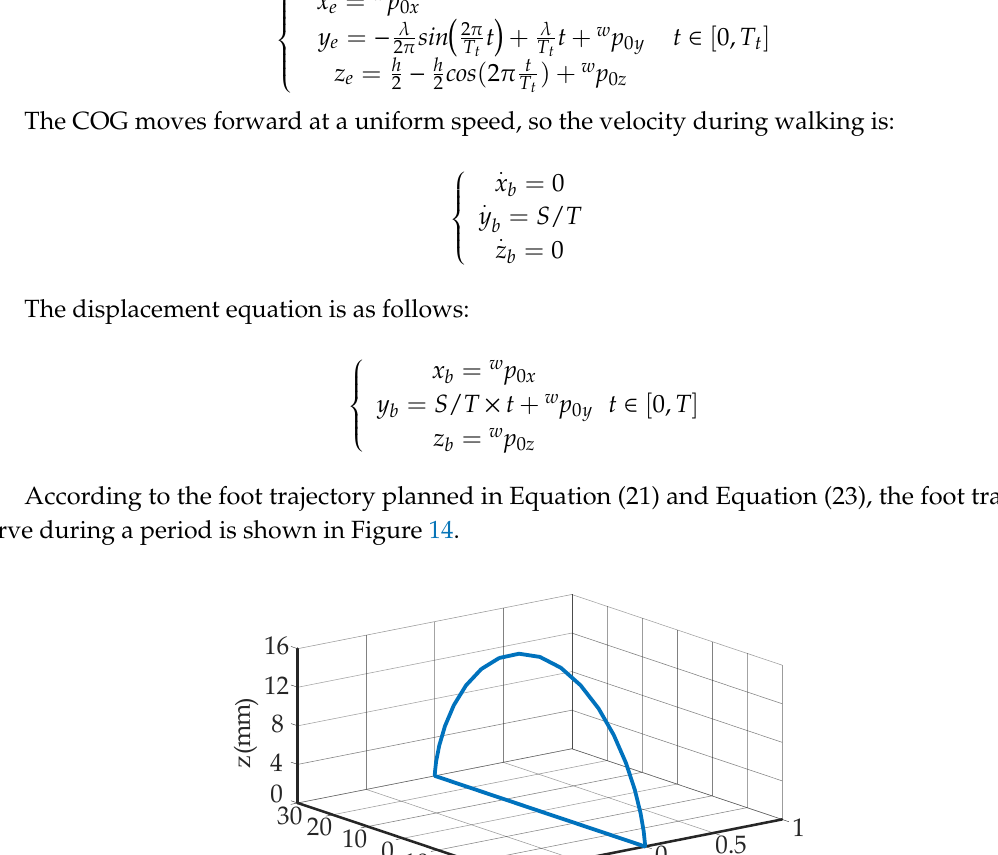
Table 3. Simulation parameters setting. Parameter